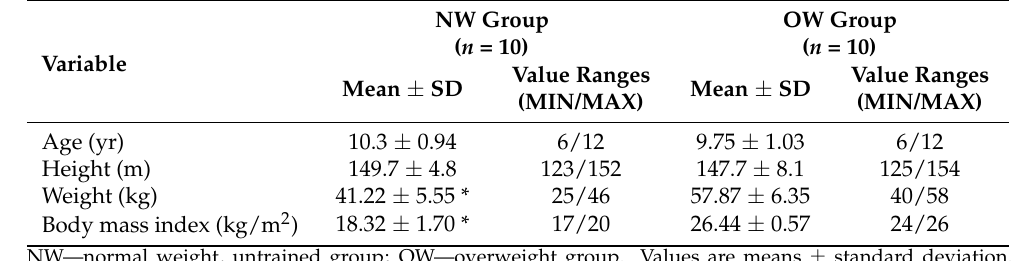
Table 2. Subjects’